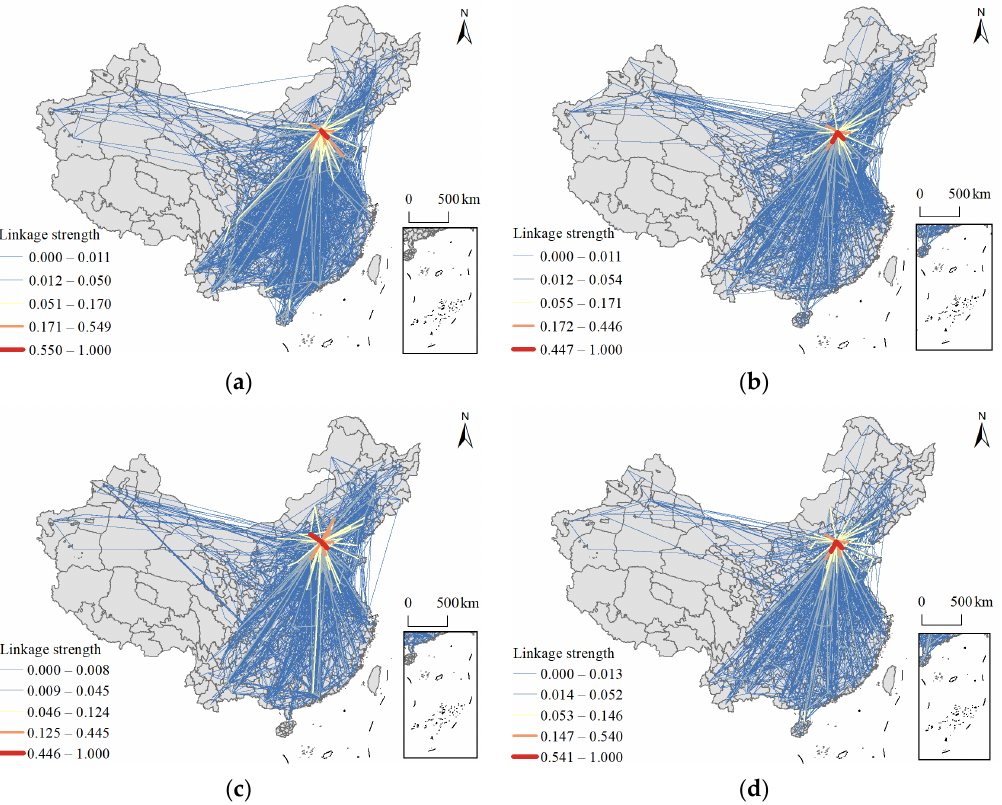
Figure 3. Spatial pattern of agricultural product circulation networks in Beijing in four seasons: ( a ) spring; ( b ) summer; ( c ) autumn; ( d ) winter.